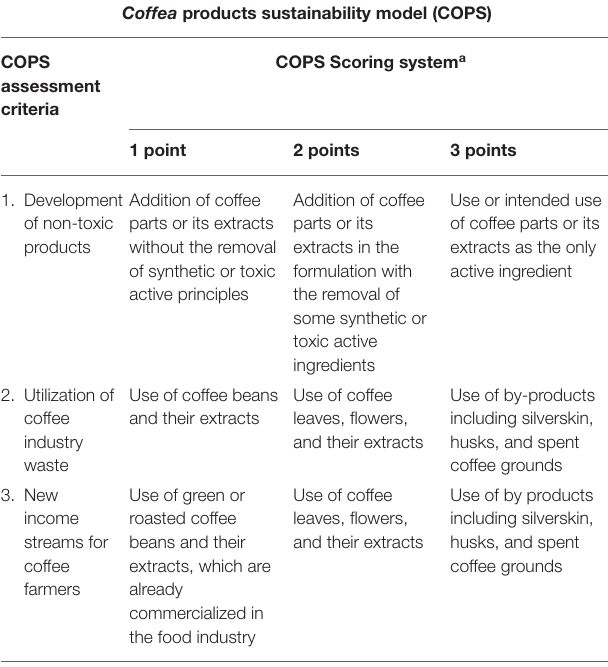
TABLE 2 | Sustainability assessment criteria and